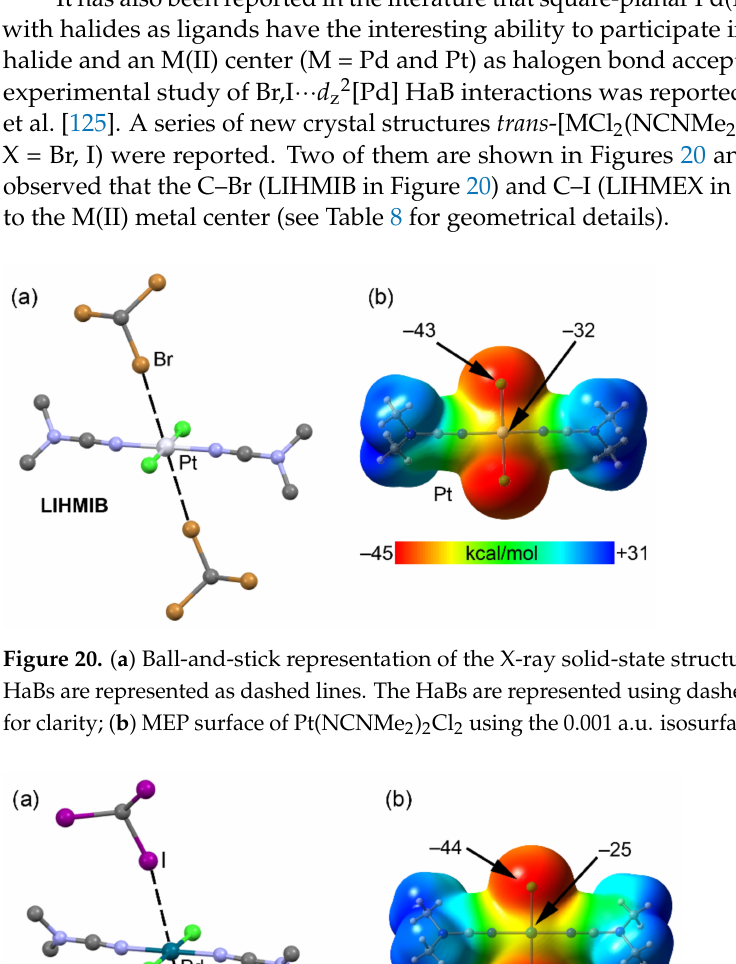
Figure 19. ( a ) Ball-and-stick representation of the X-ray solid-state structure of AMUPAC, in which HaBs are represented as dashed lines; ( b ) MEP surface of [RhCl 2 (COD)] 2 using the 0.001 a.u. isosurface (energies in kcal/mol). H atoms omitted for clarity.